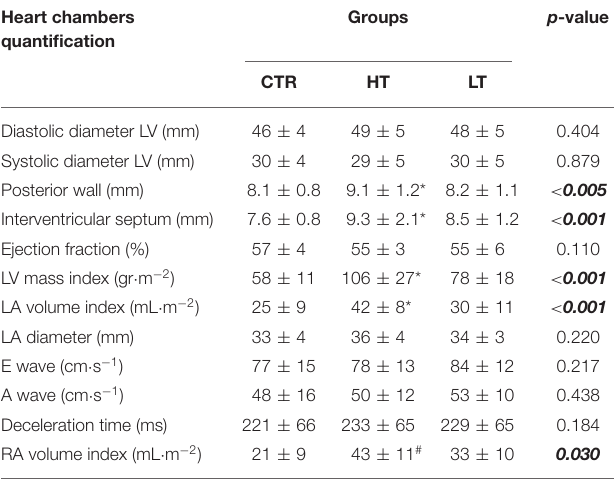
TABLE 2 | Echocardiographic characteristics of